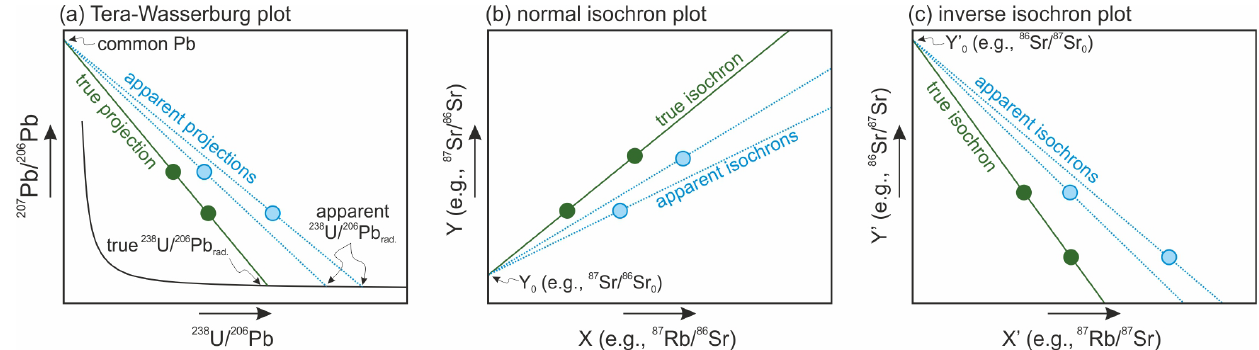
Figure 1. Schematic illustrations for how individual analyses of primary standards with variable parent and daughter isotope concentrations can be used to obtain factors for elemental-fractionation correction. Each plot shows two data points that are assumed to be corrected for mass-dependent fractionation and have different elemental-fractionation factors (e.g. due to instrument instability). (a) One of the approaches taken in U–Pb geochronological applications of LA-ICP-MS. Factors for U–Pb fractionation correction are calculated by rationing the true and apparent 238 U / 206 Pb radiogenic ratios that are obtained using the Tera–Wasserburg diagram. (b–c) Potential approaches for non-U–Pb geochronological applications of LA-ICP-MS. Factors for elemental-fractionation correction can be estimated by finding coefficients by which the measured elemental ratios need to be multiplied to equate the slopes of the apparent and true isochrons, whether normal or inverse. Elemental-fractionation correction factors can also be estimated by comparing the true and apparent intercepts with the horizontal axis in the inverse isochron